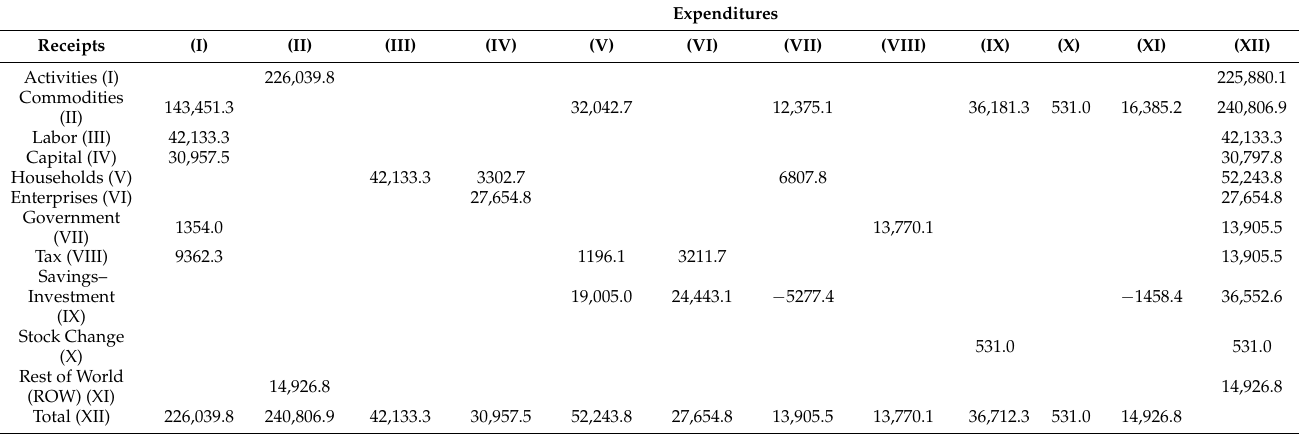
Table 1. China macro SAM 2017 (billion